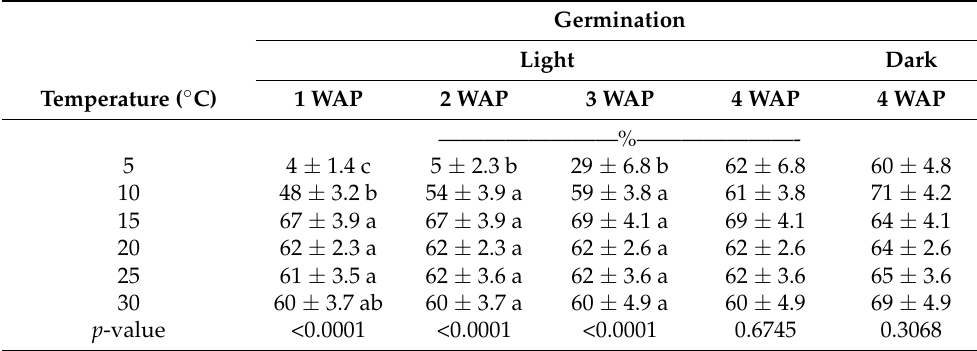
Table 1. Impact of light and temperature on white clover seed germination in environment-controlled growth chambers.